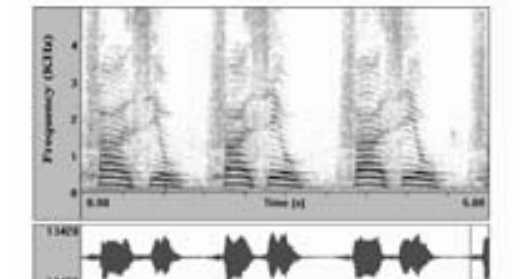
Figura 2b. TrŒs emissıes da palavra fÆcil pelo sujeito com anartria. Observe o prolongamento na emissªo do fonema /f/ nas primeiras manchas de cada par de